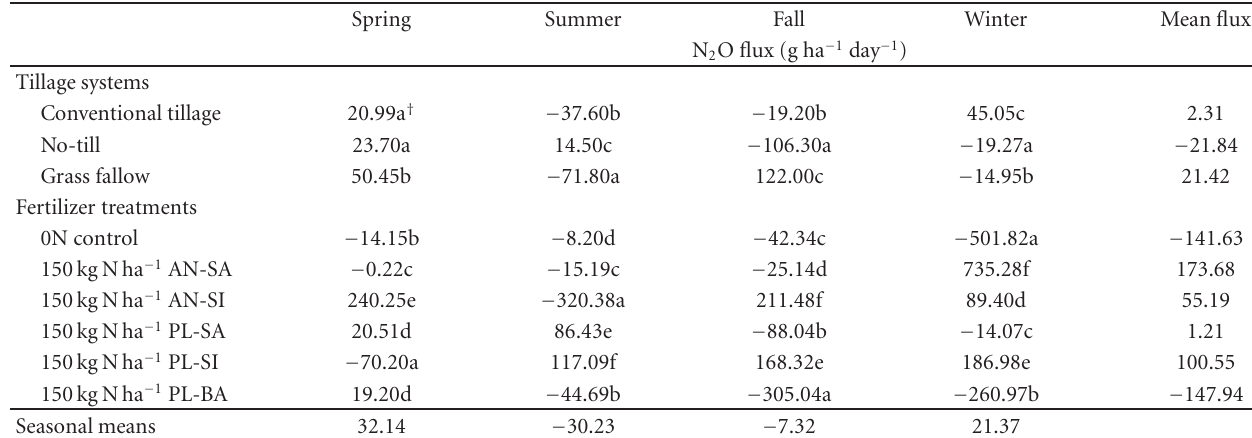
Figure 3: Soil N 2 O fluxes in corn plots receiving ammonium nitrate (AN) and poultry litter (PL) N fertilizers using surface (SA), soil incorporation (SI), and subsurface band (BA) application methods in conventional tillage (CT) and no-tillage (NT), systems, Hazel Green, Alabama. Table 4: Soil N 2 O fluxes as influenced by tillage systems and ammoniumnitrate (AN) and poultry litter (PL) N fertilizers using surface (SA), soil incorporation (SI), and subsurface band (BA) application methods in spring, summer, fall, and winter seasons, Hazel Green,